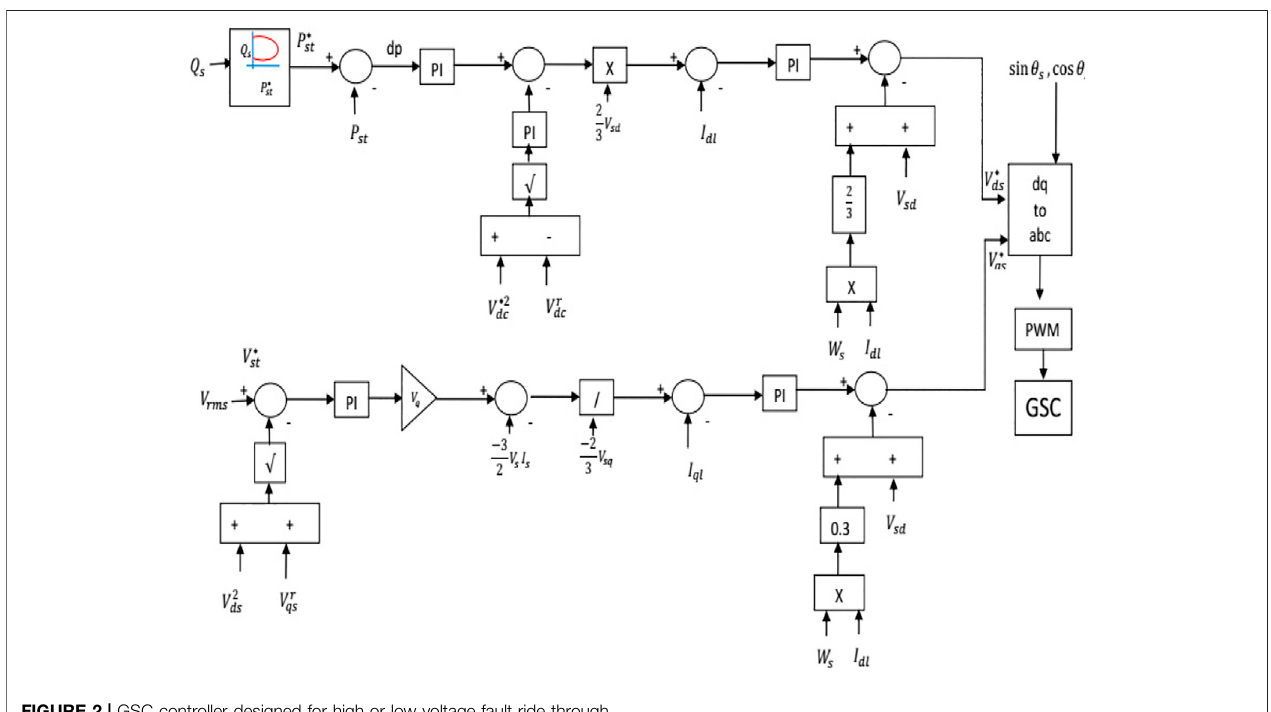
FIGURE 2 | GSC controller designed for high or low voltage fault ride